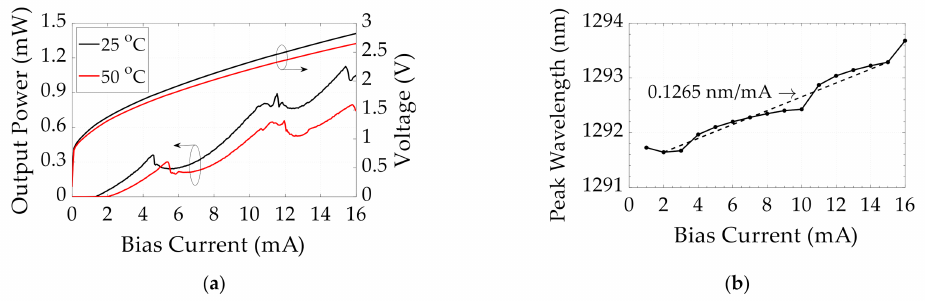
Figure 2. Static characteristics of the laser: ( a ) L-I-V curves at 25 ◦ C and 50 ◦ C based on fiber-coupled output powers; ( b ) Peak wavelength versus bias current at 25 ◦ C. The dashed line presents a linear fitting of the thermal chirp coefficient ( ∂λ / ∂ I b